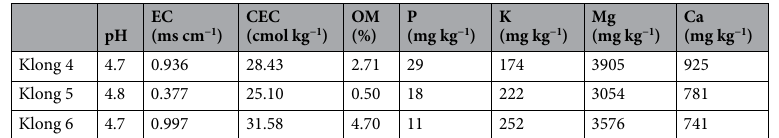
Table 2. Chemical properties and organic matter content of soil sample collected from Klong 4, 5, and 6 of Rangsit, Pathum-Thani district,